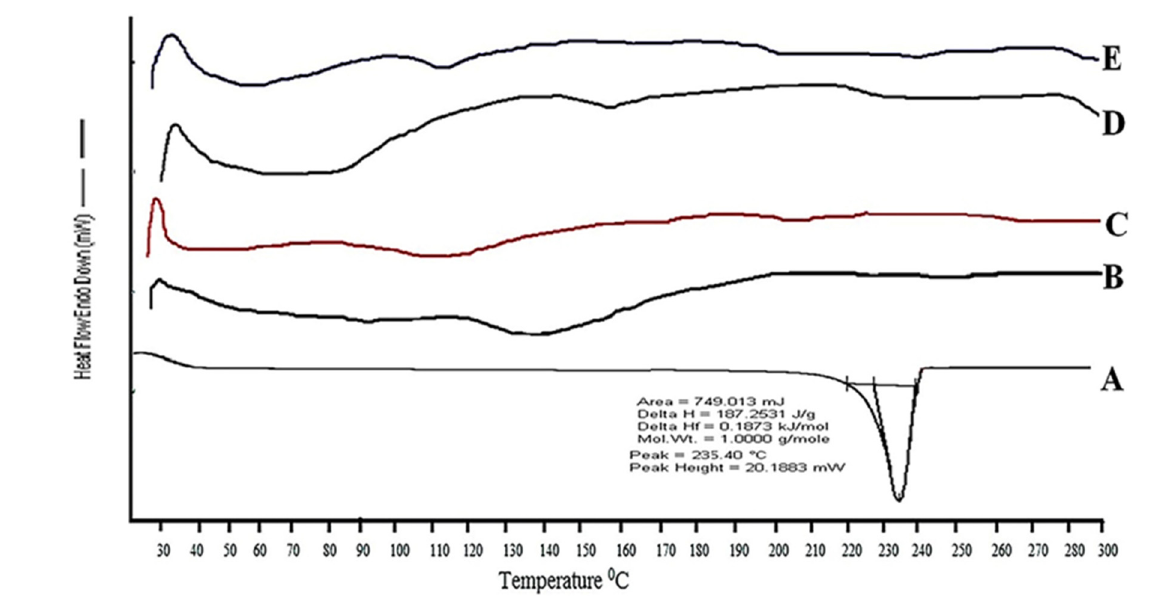
Figure 3. DSC spectra of pure cytarabine ( A ), trehalose ( B ), neat TINPs ( C ), cytarabine-loaded TINPs (CY-TINPs) ( D ), and CY-TINPs ( E ) after 3 months.